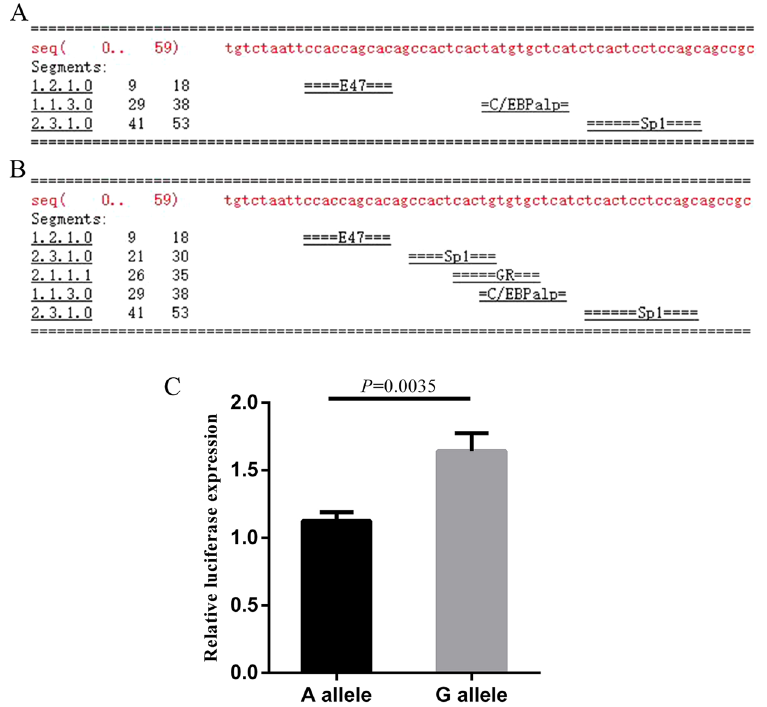
Figure 3. Identification of promoter activity in SNP rs1550117 region. Transcription factor binding sites prediction of intron 1 region containing rs1550117 G allele ( A ) and A allele ( B ). The arrow represents the transcription factor E47 binding site (CCACCAGCAC) from 9 to 18 bp. ( C ) Luciferase reporter assay of the luciferase activity of